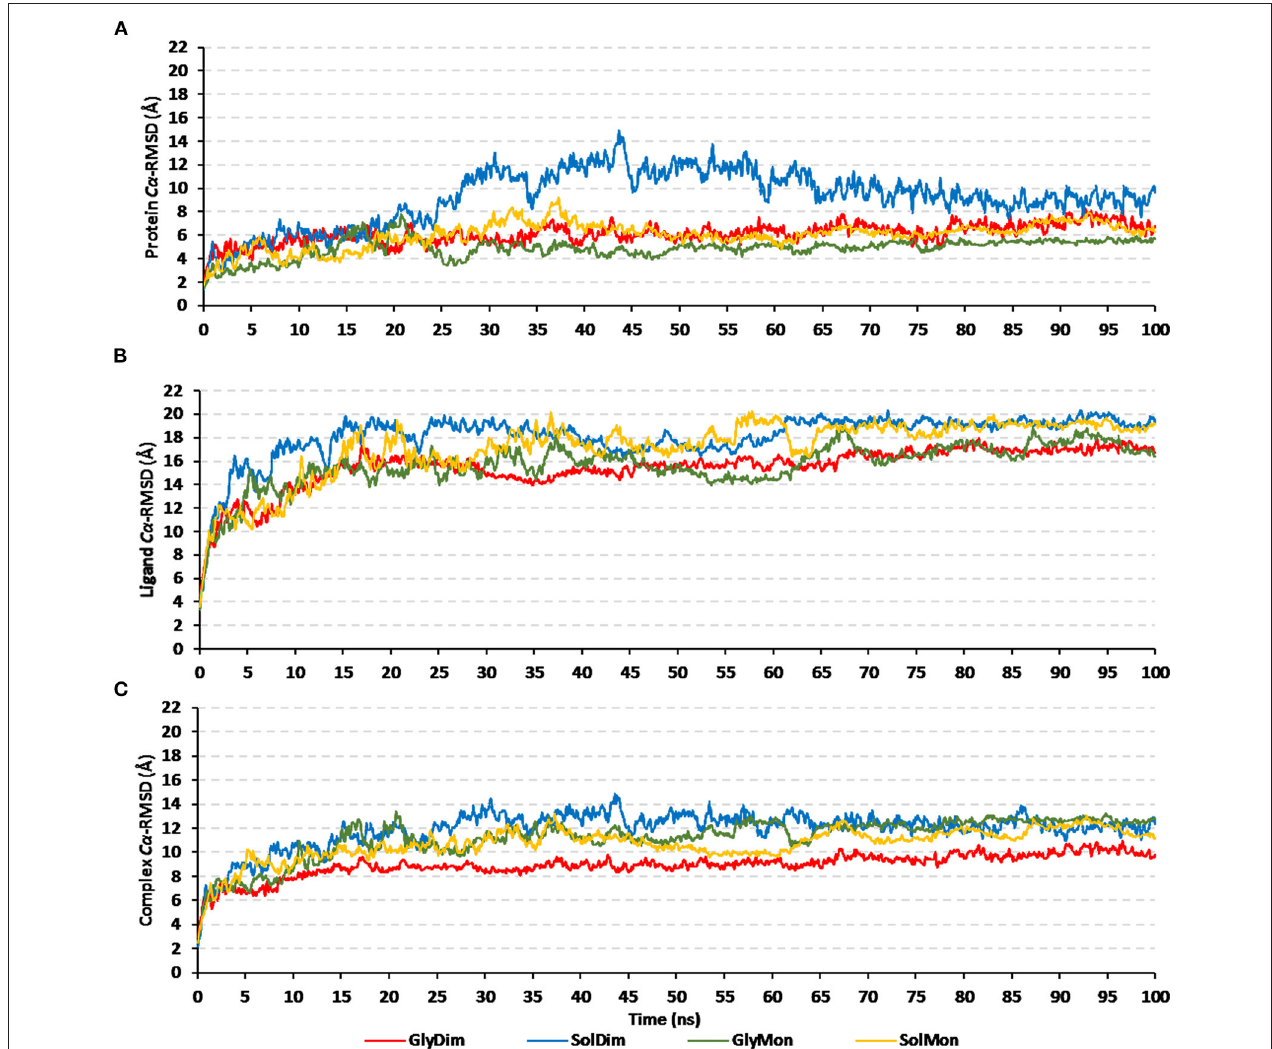
FIGURE 7 | RMSD trajectory analysis for the four investigated epitope vaccine ligand-bound h TLR-4 target models across 100 ns explicit molecular dynamics simulation runs. Time-evolution of (A) Proteins’ C α -RMSD, (B) Ligands’ C α -RMSD, and (C) Complexes’ C α -RMSD, along molecular dynamics timeframes (ns).